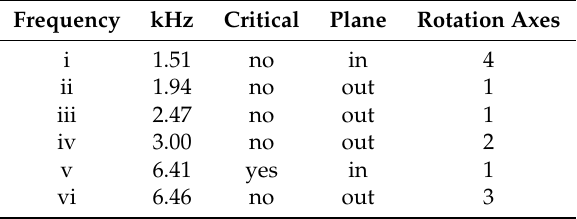
Table 1. Critical modes for comb drives